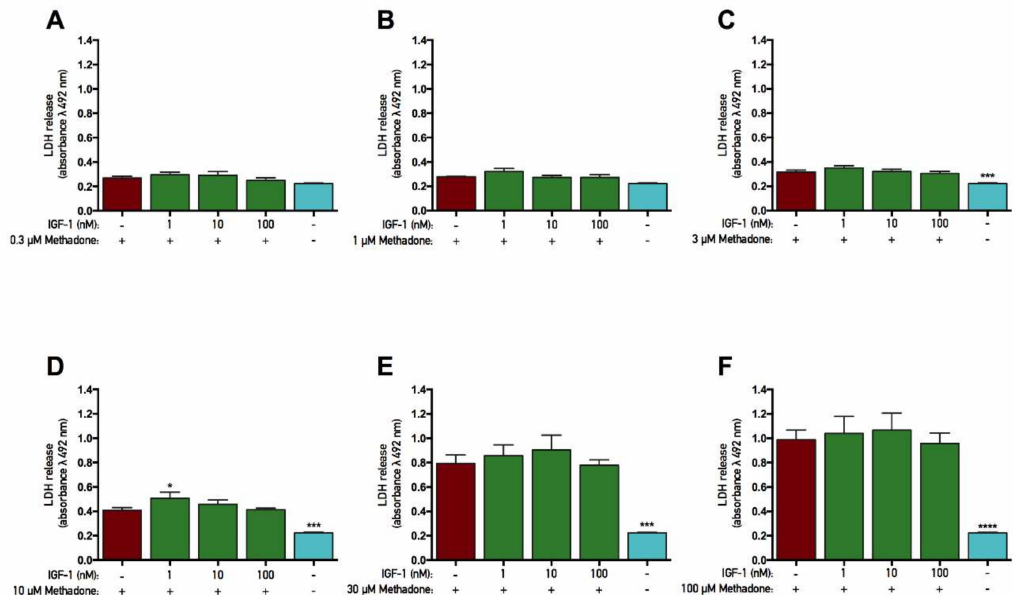
Figure 3. Insulin-like growth factor-1 does not protect against methadone-induced membrane